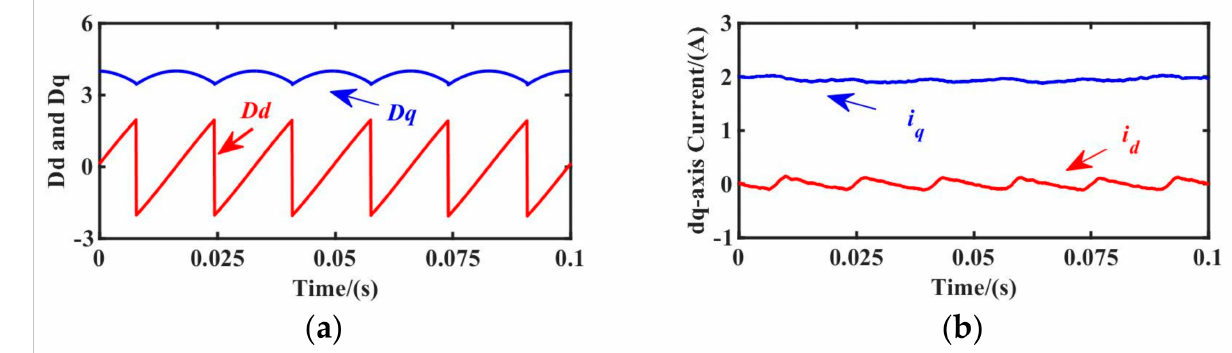
Figure 1. Simulated waveforms of computed Dd and Dq , i d and i q under i d = 0 ( γ = 0) control and 150 r/min. ( a ) Dd and Dq . ( b ) dq − axis